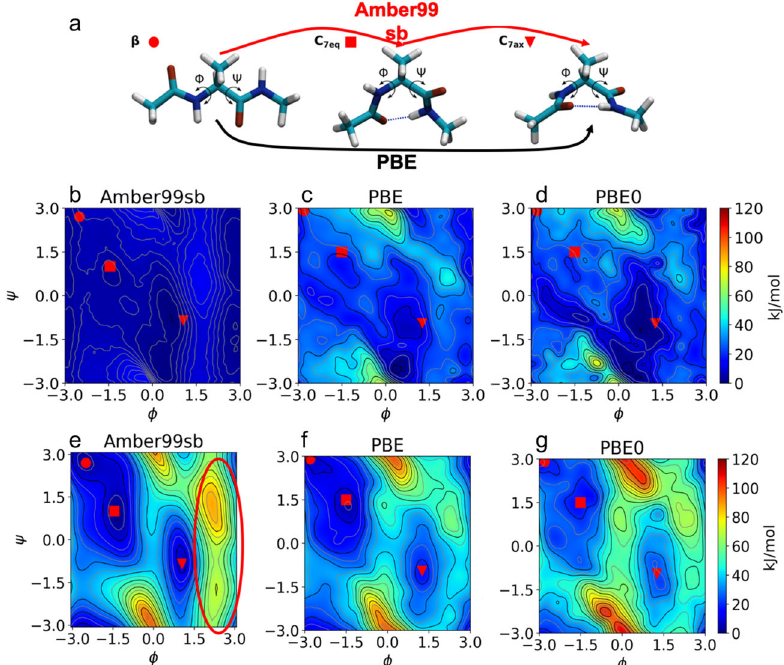
Fig. 2 Advanced sampling using fi rst principles molecular dynamics simulations. Representation of the three metastable minima, β , C 7eq , and C 7ax of the alanine dipeptide together with the two angles ( φ , θ ) used as bias (panel a ). Entropic ( b , c , d panels) and potential energy ( e , f , g panels) contributions to the free energy surface of the alanine di-peptide as a function of the illustrated torsion angles 49 . Free energies are obtained with the force fi eld Amber99sb 43,147 and with fi rst principles calculations with semi-local (PBE 74 ) and hybrid (PBE0 71,73 ) functionals. The arrows in panel a indicate the minimum free energy path. The circled region in panel e shows signi fi cant overestimation of repulsive forces in the classical model. Adapted with permission from ref. 49 , copyright (American Chemical Society,